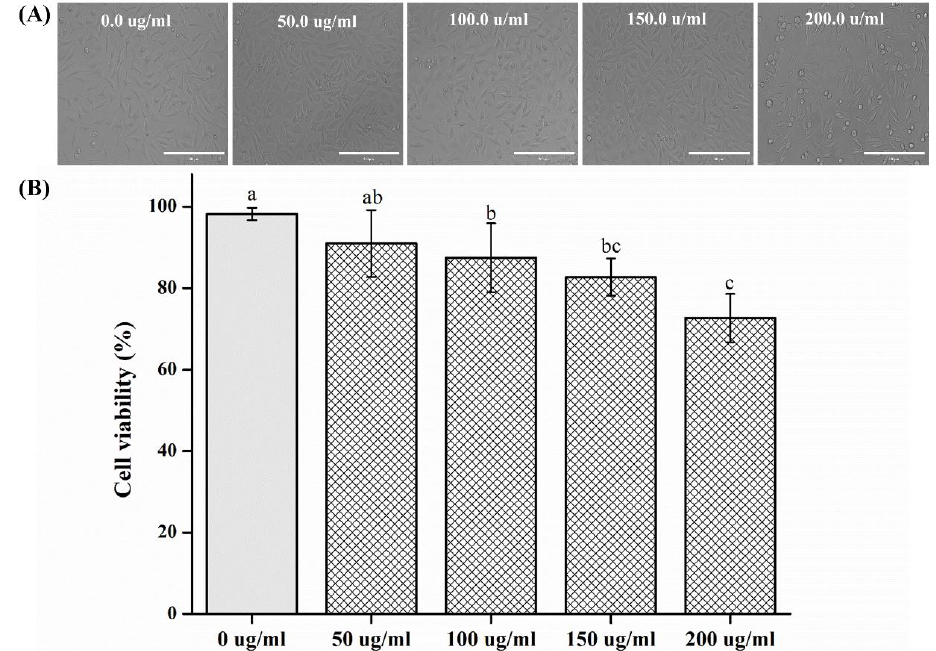
Figure 5. ( A ) Representative microscopic images of L929 cells: 0, 50, 100, 150, and 200 µ g / mL at 20 × magnification. ( B ) Comparison of cell viability among different groups. Different letters above bars indicate significant differences ( p < 0.05).